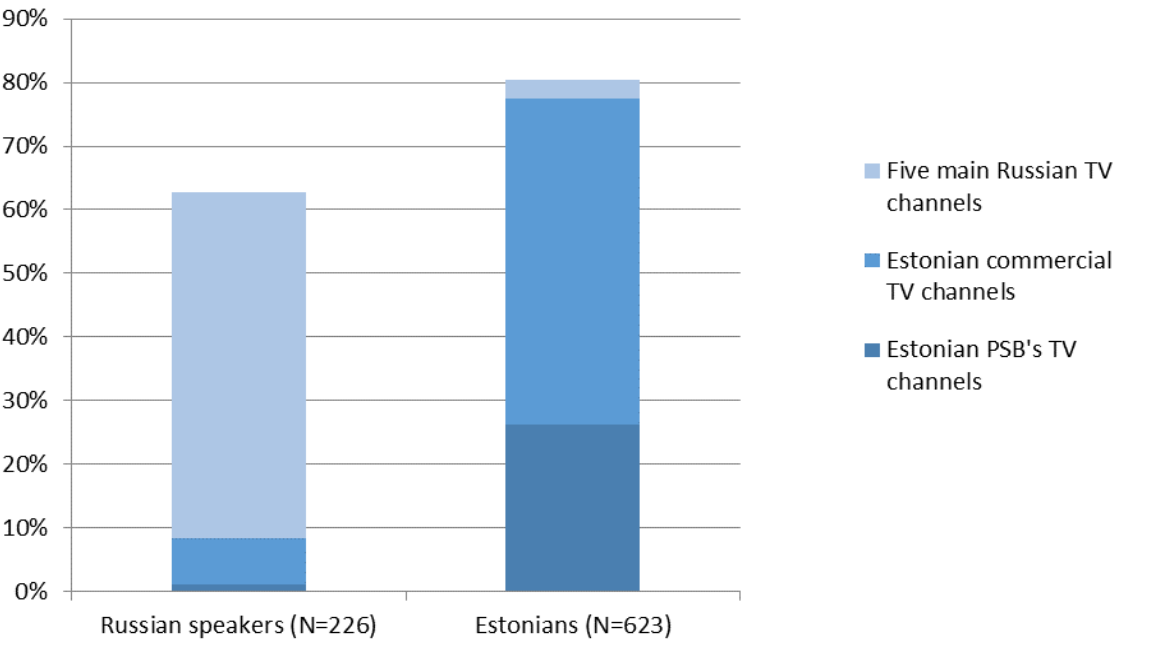
Figure 4. Average weekly share of viewing in Estonia in 2014. Age group 4+, Estonians and Russian speakers. Source: Author’s calculations based on TNS Emor data